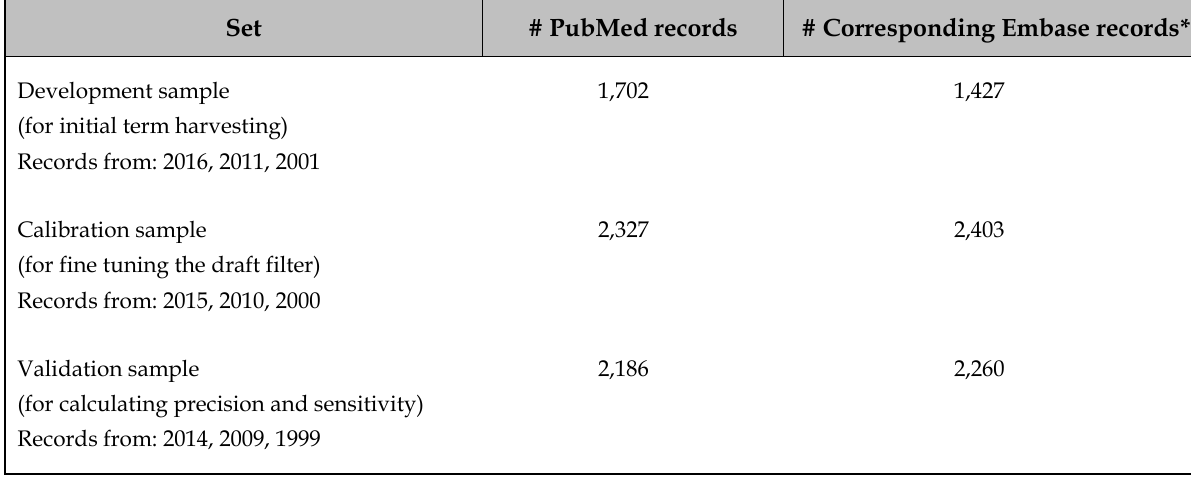
Table 1 Sample sizes for the three reference samples collected based on identified PubMed records